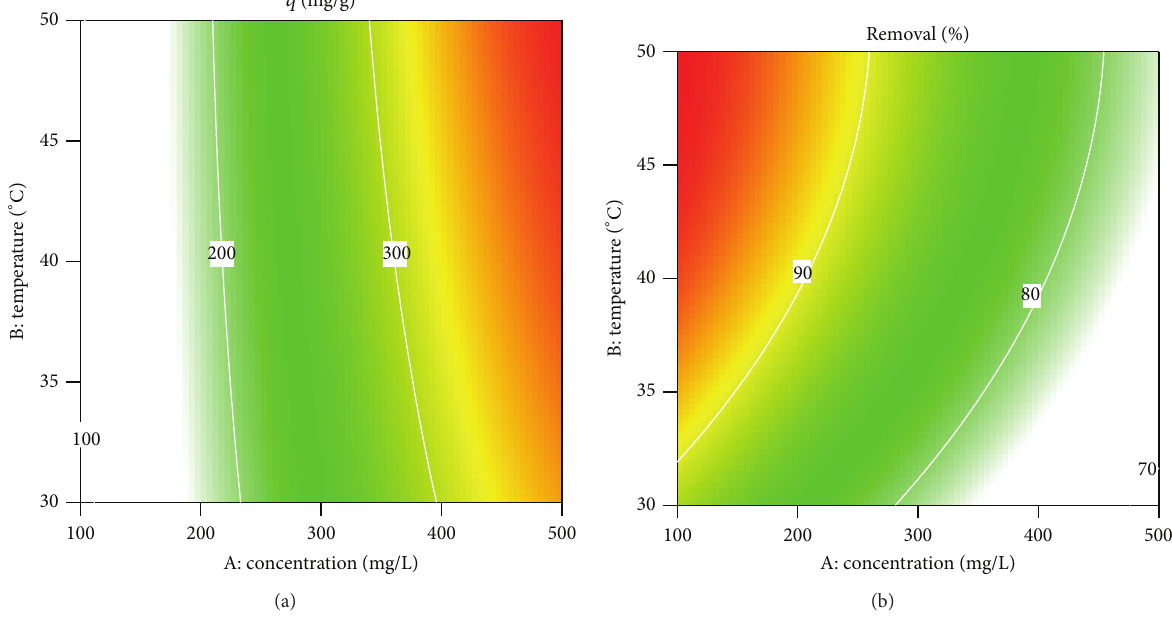
Figure 4: Two-dimensional contour plots: (a) combined effects of TB AGLF concentration and temperature on the adsorption capacity of sunflower pulp and (b) combined effects of TB AGLF concentration and temperature on percent TB AGLF removal by sunflower